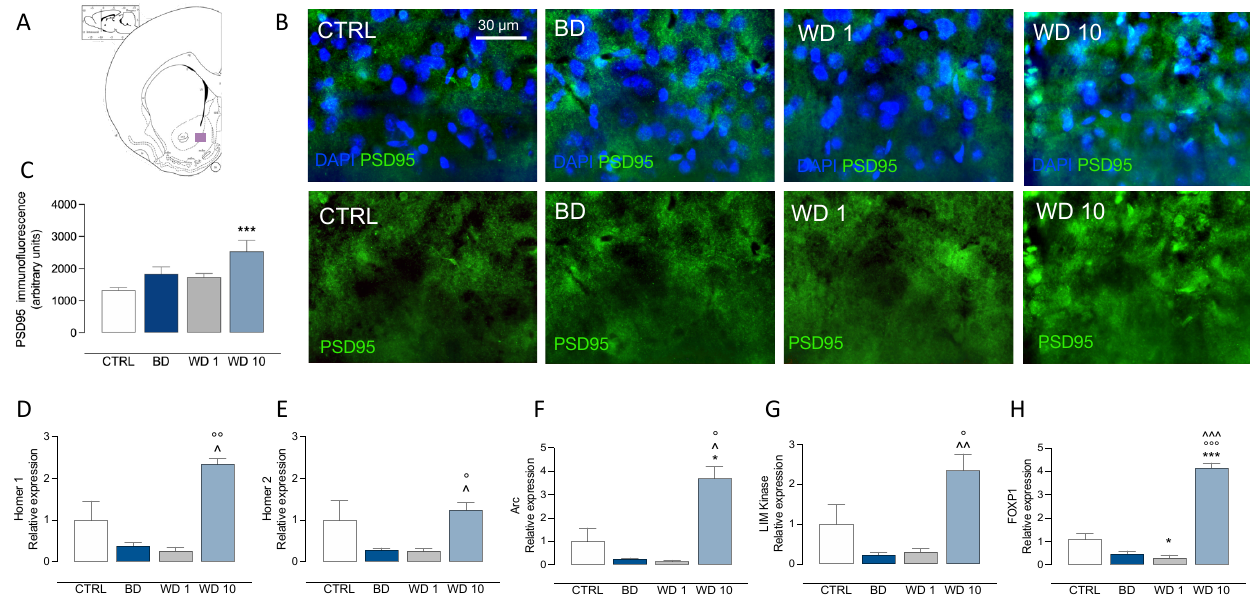
Figure 4. Binge-like alcohol exposure during adolescence perturbs post-synaptic excitatory signaling in the NAc. ( A – H ) Rats exposed to binge-like alcohol drinking during adolescence show altered levels of post-synaptic markers of glutamate neurotransmission and activity-regulated proteins at late withdrawal in the NAc. In particular, we observed ( B , C ) increased PSD95-positive immunofluorescence at WD10, when compared with CTRL (*** p < 0.001) group; in addition, we found ( D ) increased Homer 1 mRNA relative expression at WD10 when compared to BD (ˆ p < 0.05) and WD1 ( ◦◦ p < 0.01), and ( E ) increased Homer 2 relative expression at WD10 with respect BD (ˆ p < 0.05) and WD1 ( ◦ p < 0.05) groups. Besides this, ( F – H ) a significant increase of activity-regulated proteins expression was observed at WD10, as to ( F ) increased Arc relative expression at WD10, with respect to CTRL (* p < 0.05), BD (ˆ p < 0.05) and WD1 ( ◦ p < 0.05); ( G ) increased LIM Kinase 1 relative expression at WD10, with respect to BD ( p < 0.01) and WD1 ( ◦ p < 0.05); (H) increased FOXP1 relative expression when compared with CTRL (*** p < 0.001), BD (ˆˆˆ p < 0.001) and WD1 ( ◦◦◦ p < 0.001). NAc: nucleus accumbens; PSD95: post-synaptic density protein 95; Arc: activity-regulated cytoskeleton-associated protein; LIM Kinase: LIM Kinase 1; BD: binge day; WD1: withdrawal day 1; WD10: withdrawal day 10; CTRL: water-exposed control group. Each bar represents the mean of n = 7 rats; error bars indicate SEM. All expression values were normalized to control